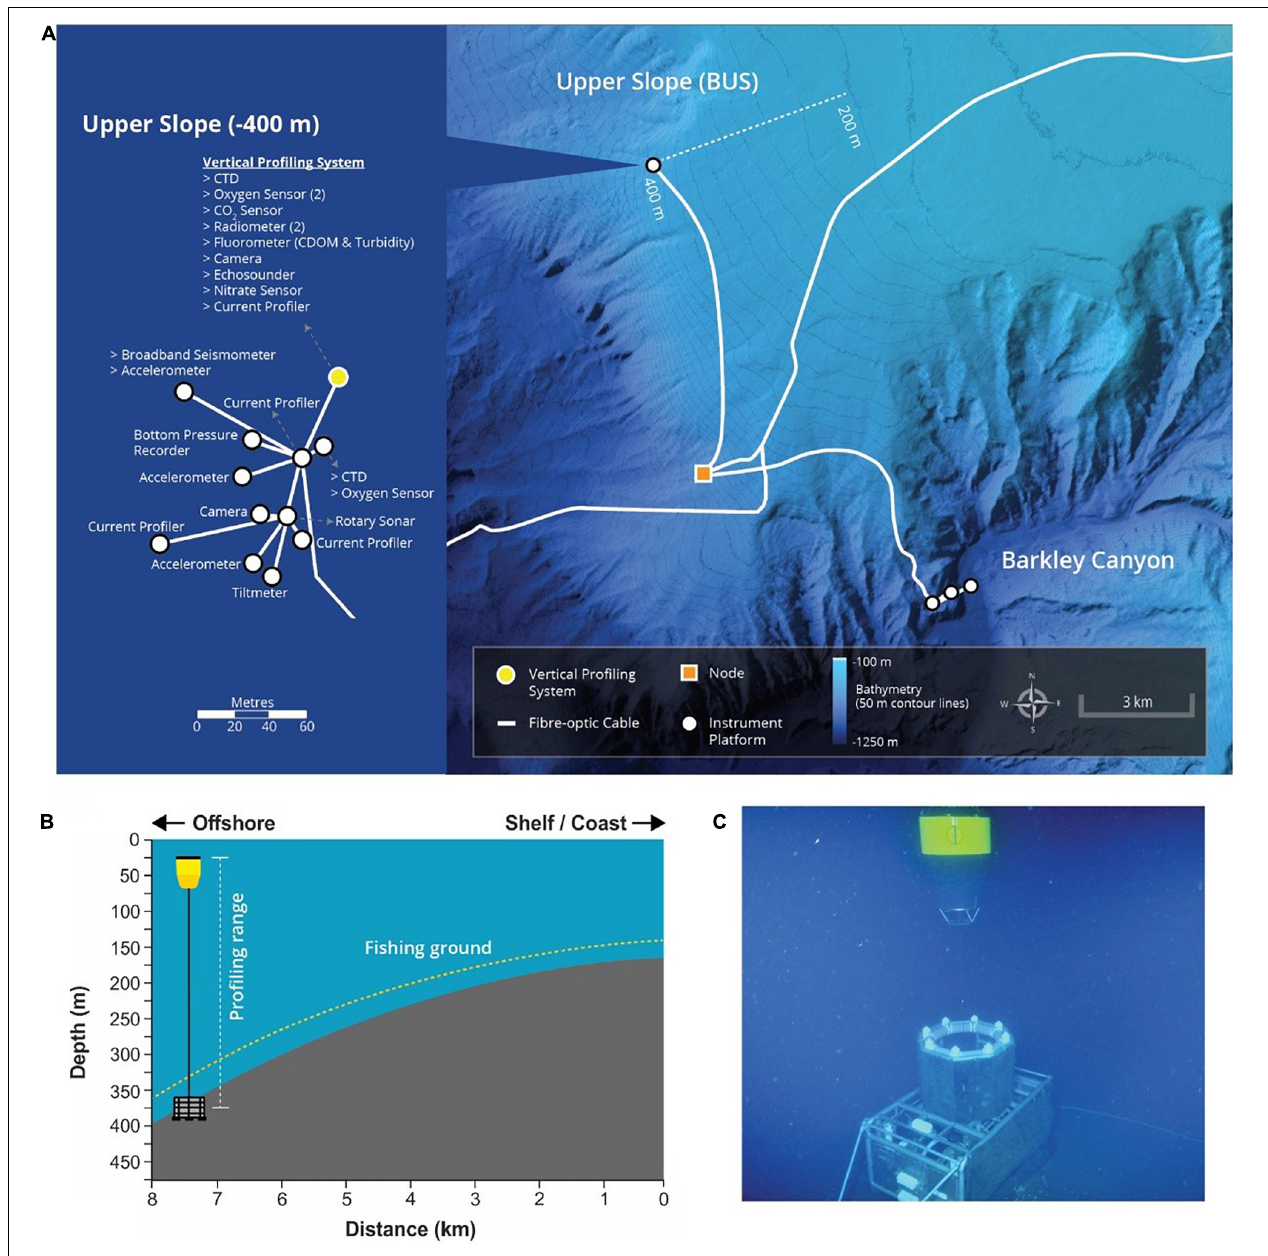
FIGURE 2 | (A) Detailed bathymetric map of the Barkley Canyon and its upper slope, and the instrument platforms/pods (white dots) that are connected to the Barkley Canyon node (orange square) as part of the Ocean Networks Canada’s NEPTUNE cabled seafloor observatory. A detailed description of the different sensors and instruments installed in the Vertical Profiling System (VPS) is also provided in this figure. (B) Bathymetric cross-section of the white dotted line in panel (A) , and the location of the VPS at the upper slope region off Vancouver Island. (C) Underwater photography of the VPS and its cage. For interpretation of the references to color in this figure legend, the reader is referred to the web version of this